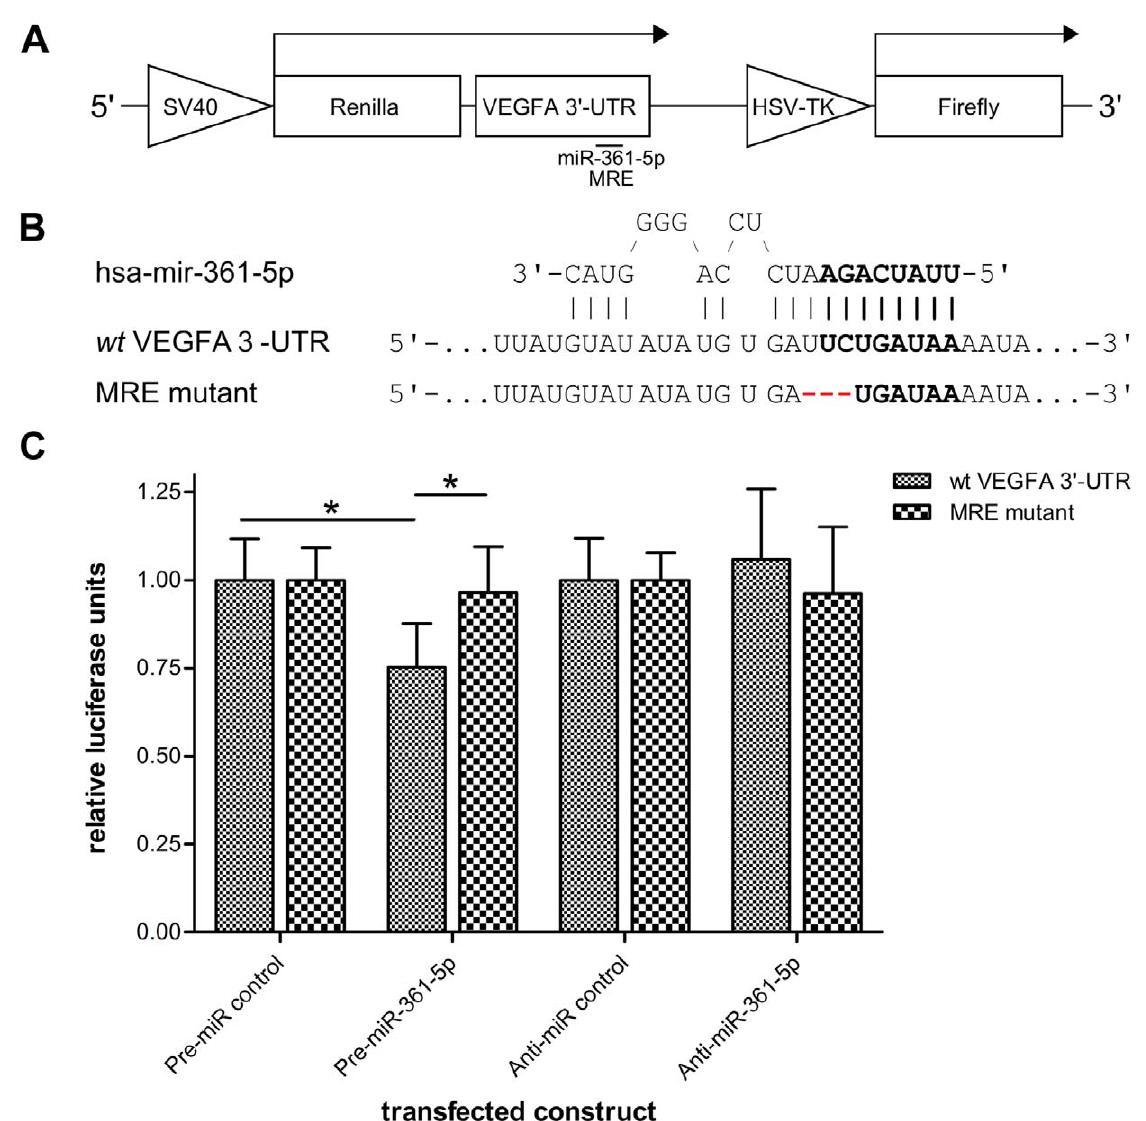
Figure 1. Mutation of the putative recognition element abolishes miRNA-361-5p-mediated regulation of a VEGFA 3 9 -UTR reporter. (A) Schematic representation of the luciferase reporter constructs, indicating the VEGFA 3 9 -UTR fragment fused to Renilla luciferase, the predicted miRNA recognition element (MRE) for miR-361-5p, and the firefly luciferase gene used for normalization. (B) Sequence alignment of miR-361-5p with the wild type (wt) VEGFA 3 9 -UTR and mutated reporter. The seed sequence (bold) and mutated residues (red) are highlighted. (C) HEK293 cells were co-transfected with either of the indicated luciferase reporters and a miR-361-5p mimic, antisense inhibitor, or the respective control. Data were obtained from three independent experiments, performed in triplicate. For each experiment, mean ratios of Renilla and firefly luciferase activities were normalized to those of psiCHECK-2-transfected cells, then to Pre- or Anti-miR control-transfected cells. Mean values of three independent experiments 6 S.D. are plotted. Two-tailed, unpaired t -tests were used to calculate P values (single asterisks denote P values , 0.05). doi:10.1371/journal.pone.0049568.g001 Figure 3B). With a Spearman’s rank correlation coefficient of the compared to the VEGFA-expressing epithelial cells (fold differ- D C 2 0.80 (two-tailed) across all cell lines, the ences between LEC/BEC and A431/HaCaT ranging from 23.72 T values of r= to 47.82; P values between 0.0064 and 0.0120; unpaired t -test, two expression levels of miR-361-5p and VEGFA correlated well in an tailed; Figure 3A). Conversely, while VEGFA mRNA levels inverse manner, although this correlation did not reach signifi- differed only slightly within the two groups of cells (fold difference cance. In summary, these data indicate that miR-361-5p is between A431 and HaCaT= 3.86 + 1.48–1.07; P= 4.0 6 10 2 8 ; fold expressed in all of the tested skin-derived cell lines, with the highest levels occurring in endothelial cells. Considering the observed difference between LEC and BEC = 1.46 + 5.12–1.13), the epithe- relation between miRNA and VEGFA levels, it is possible that lial cells contained considerably higher amounts of VEGFA miR-361-5p might play a role in maintaining the functional mRNA compared to the endothelial cells (fold differences between balance of differential VEGFA expression between epithelial and A431/HaCaT and LEC/BEC ranging from 70.43 to 378.41; P endothelial cells in the skin. values between 0.0019 and 0.0101; unpaired t -test, two tailed;